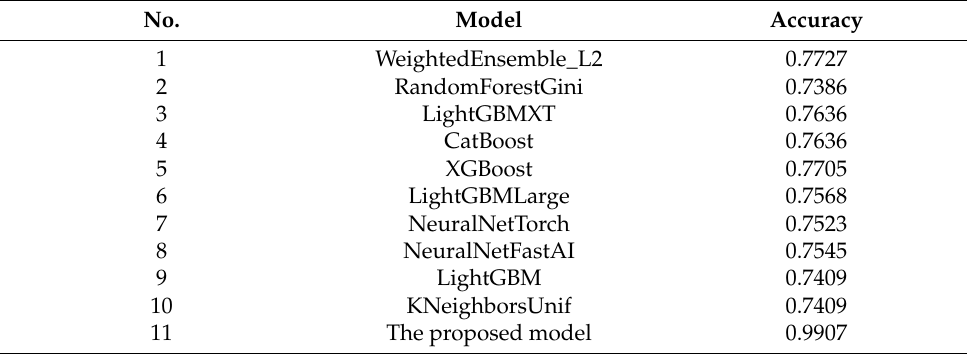
Table 3. Accuracy results for several networks trained by AutoGluon.